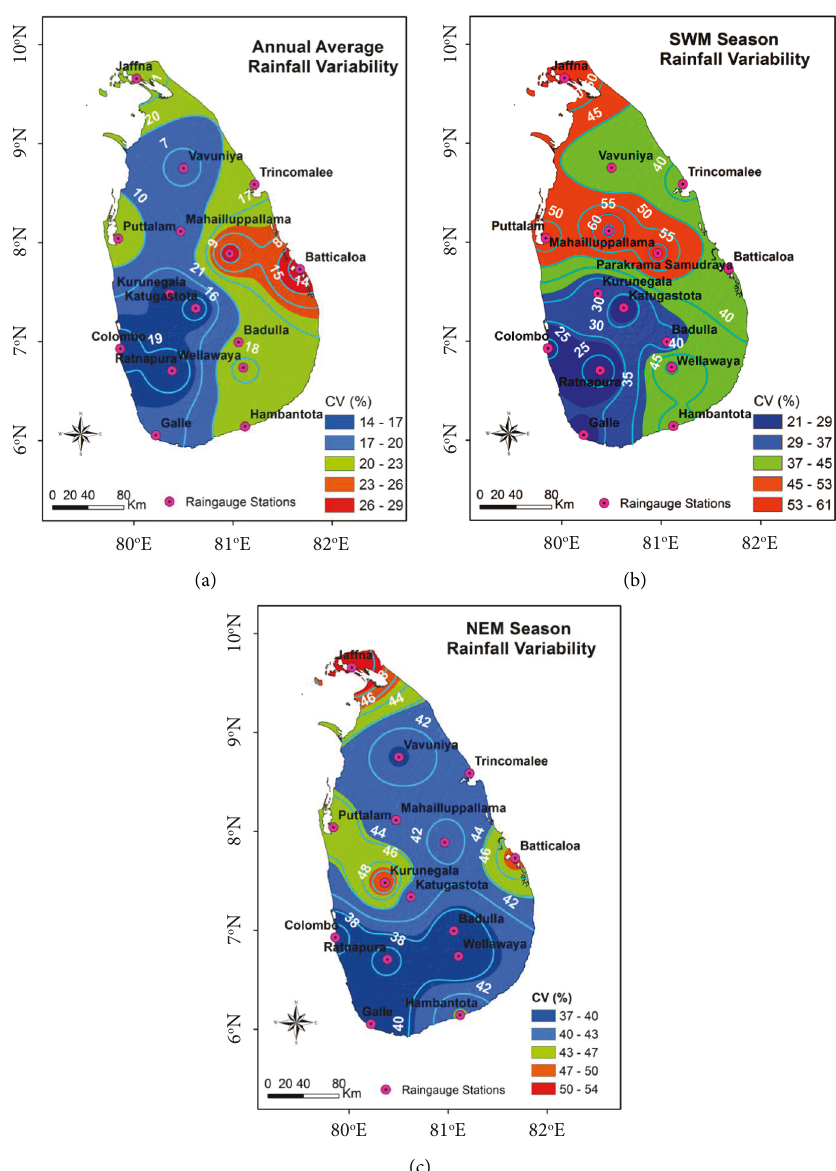
Figure 2: Spatial distribution of rainfall variability at annual and seasonal timescale. (a) For annual average. (b) For SWM season. (c) For NEM